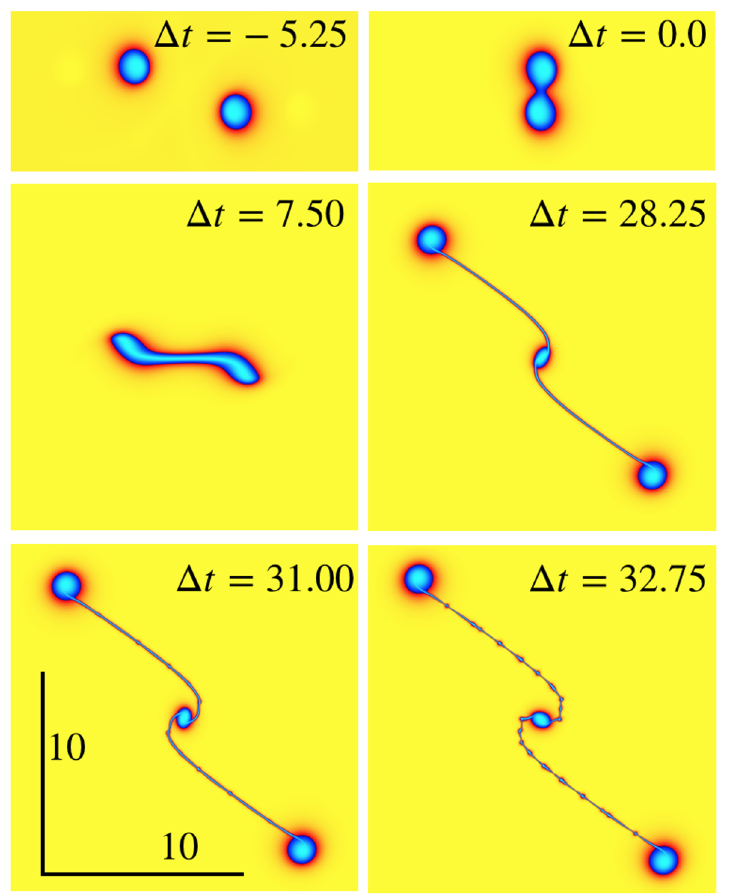
Figure 1 . Snapshots of the 7 D evolution with collision velocity v = 0 . 5 , dimensionless spin a = 0 . 7 , and impact parameter b = 2 . 2 , at times ∆ t = t − t . They correspond to: initial condition, merger merger, bar formation, first generation, second generation, latest stage. We show a spatial length of 10 units on the bottom left